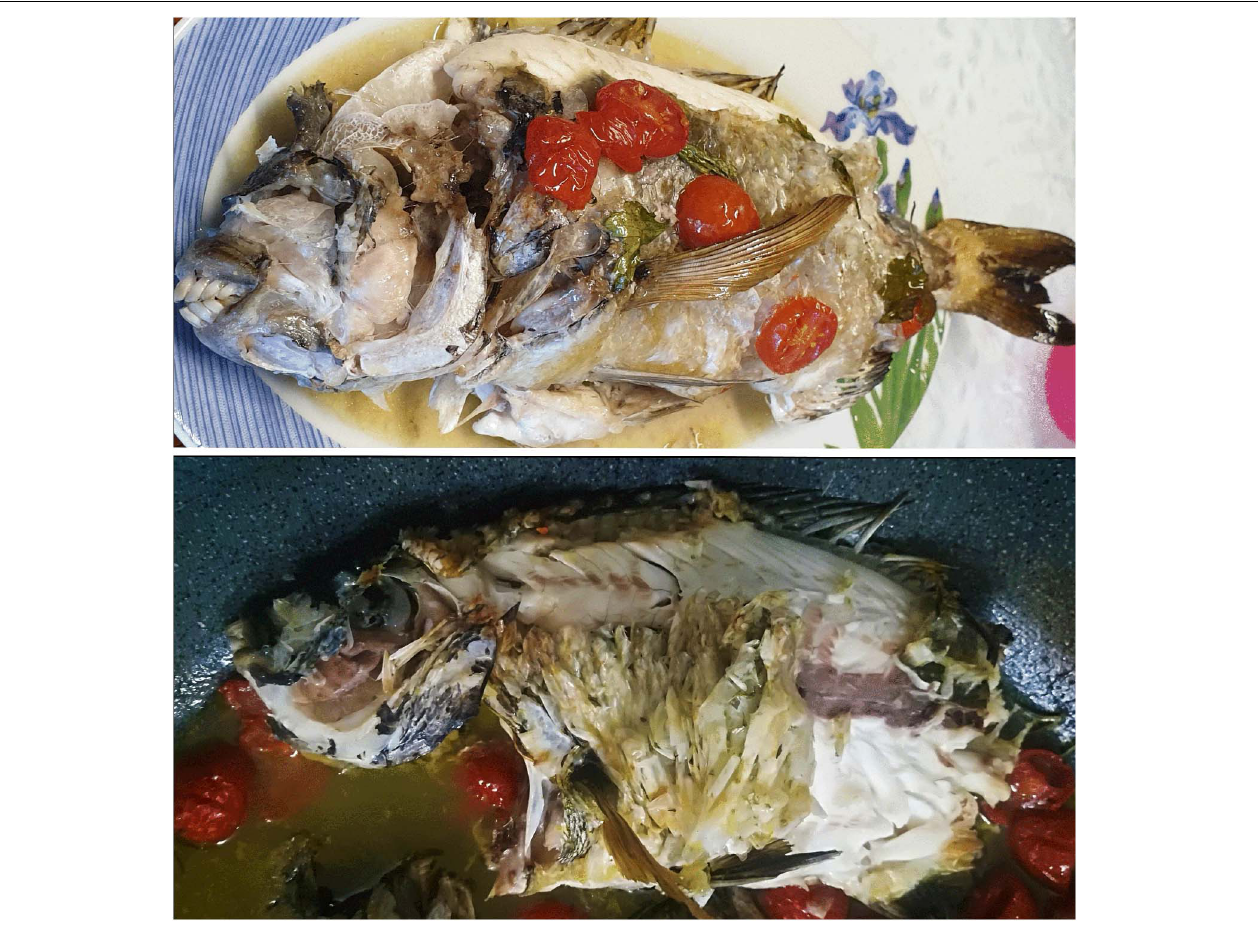
FIGURE 2 | The Abnormally Tough Specimen condition. Adult D. sargus exhibiting the ATS condition as a cooking response. For a detailed description of the filet appearance and organoleptic tests refer to Section